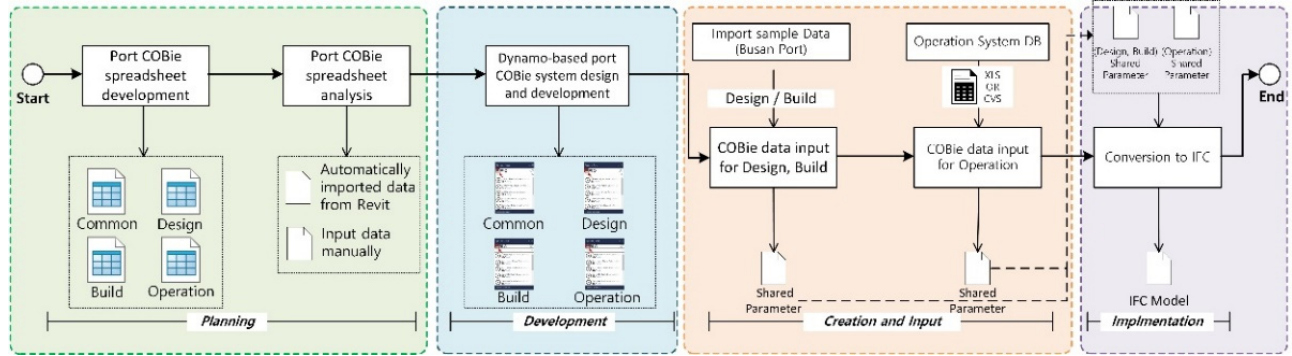
Figure 11. The process of Dynamo modeling for port COBie system.